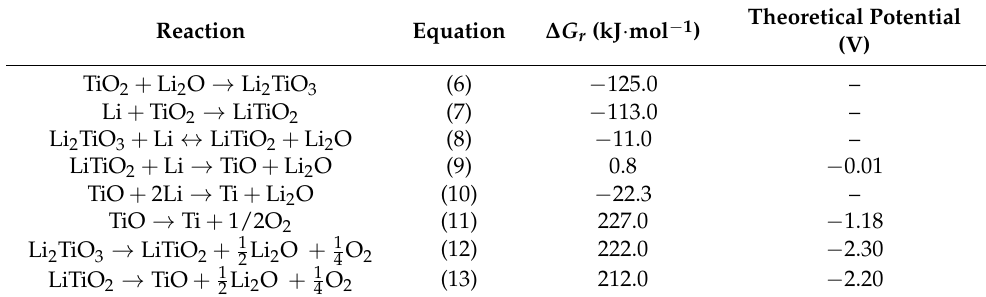
Table 2. Gibbs free energy change and reaction potentials for reactions at 650 ◦ C using DFT calcula-